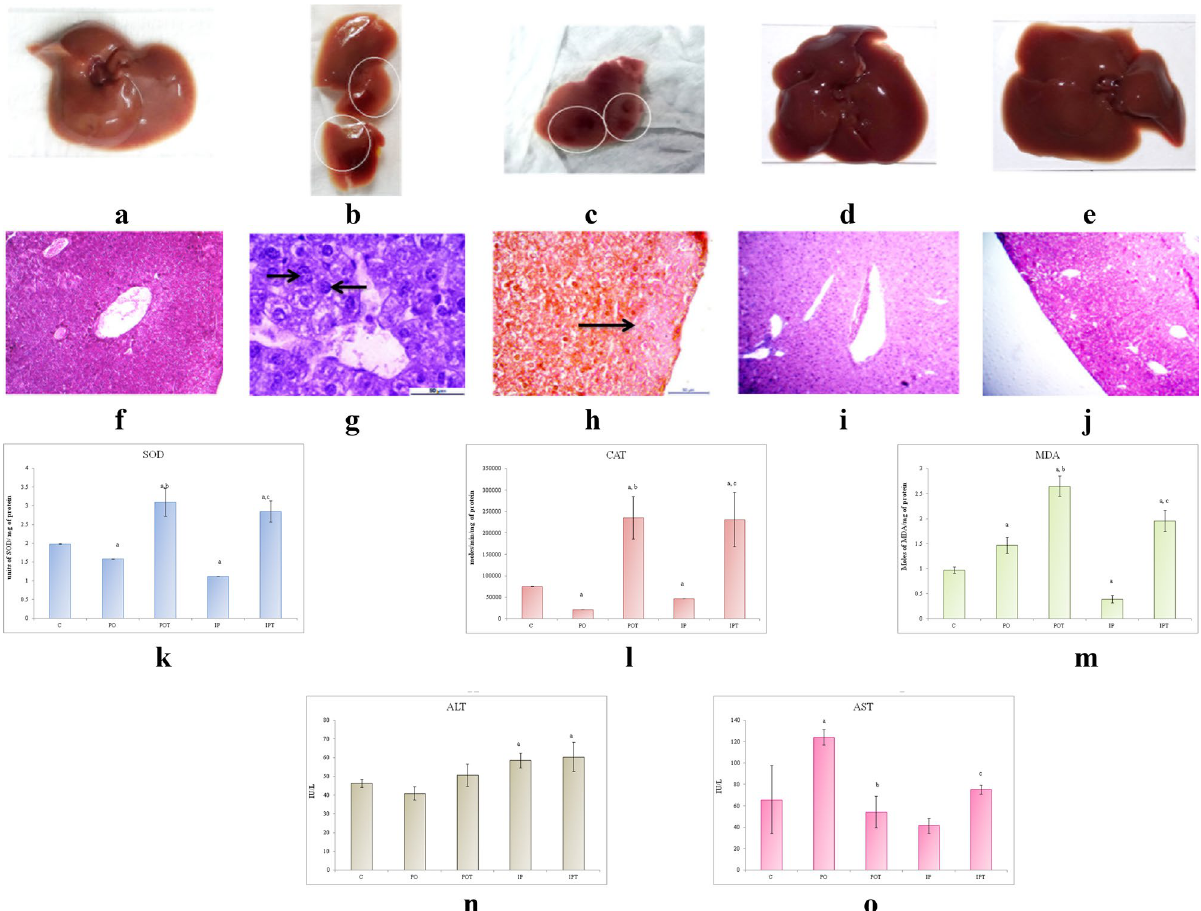
Figure 4. Photographs of liver of ( a ) control, ( b ) PO group showing discolouration as indicated by circles, ( c ) IP group showing gross lesions as indicated by circles, ( d ) POT treatment group with no pathological changes, ( e ) IPT group with no pathological changes. Photomicrographs of TS of liver of ( f ) control (HE, ×100), ( g ) PO group (HE, ×400) showing karyomegaly. Arrow indicates enlargement of hepatocytes and nucleus (HE, ×400) ( h ) IP group (HE, ×100) showing hemorrhagic necrosis (arrow) ( i ) POT-treated group, showing normal histology (H/E, ×100), ( j ) IPT-treated group (HE, ×100). ( k ) Comparison of SOD activity in liver of the control, experimental and treated animals. ( l ) Comparison of CAT activity in liver of control, experimental and treated animals. ( m ) Comparison of MDA activity in liver of control, experimental and treated animals. ( n ) Comparison of ALT activity in liver of control, experimental and treated animals. ( o ) Comparison of AST activity in liver of control, experimental and treated animals. The results of biochemical assays are shown in mean ± SE (‘a’ symbolizes p < 0.005 control vs experimental groups, ‘b’ symbolizes p < 0.005 experimental vs treatment groups (PO vs POT) and ‘c’ symbolizes p < 0.005 IP vs normal. The SOD and CAT activities in the MI groups were less than that of the control group but were very high in the IPT and POT groups (Fig. 8f,g). The results of the MDA showed different trends in both the routes of administration (Fig. 8h). The intraperi- toneal route showed a slight decrease in MDA activity which further decreased on treatment. On the contrary, MDA activity was very high in the oral route which decreased after Cin treatment. Heart. The histological section showed cyst and haemorrhage in the ventricular region of heart of MI group when compared to the control group (Fig. 9a–c). The inflammatory cells were also observed in the tissue around the cyst. The Cin treatment maintained the normal architecture of cardiac tissues and the levels of all the three enzymes that were examined (Fig. 9d,e). ROS studies were in agreement with the above results. The histology showed that TeA affected the heart as well. Low SOD, CAT and high MDA showed that TeA stimulated OS (Fig. 9f–h). Notably high values of AST were recorded in the prophylaxis group while changes in the MI groups were not significant (Fig. 9i). Brain. TeA lowered the activity of both SOD (Fig. 10a) and CAT (Fig. 10b) whereas LPO (Fig. 10c) was profoundly increased in the brain. The prophylactic groups showed an increase in the activity of all the three enzymes. Rendering to the anti-oxidant effect of cinnamaldehyde, the oxidative stress in the MI groups was